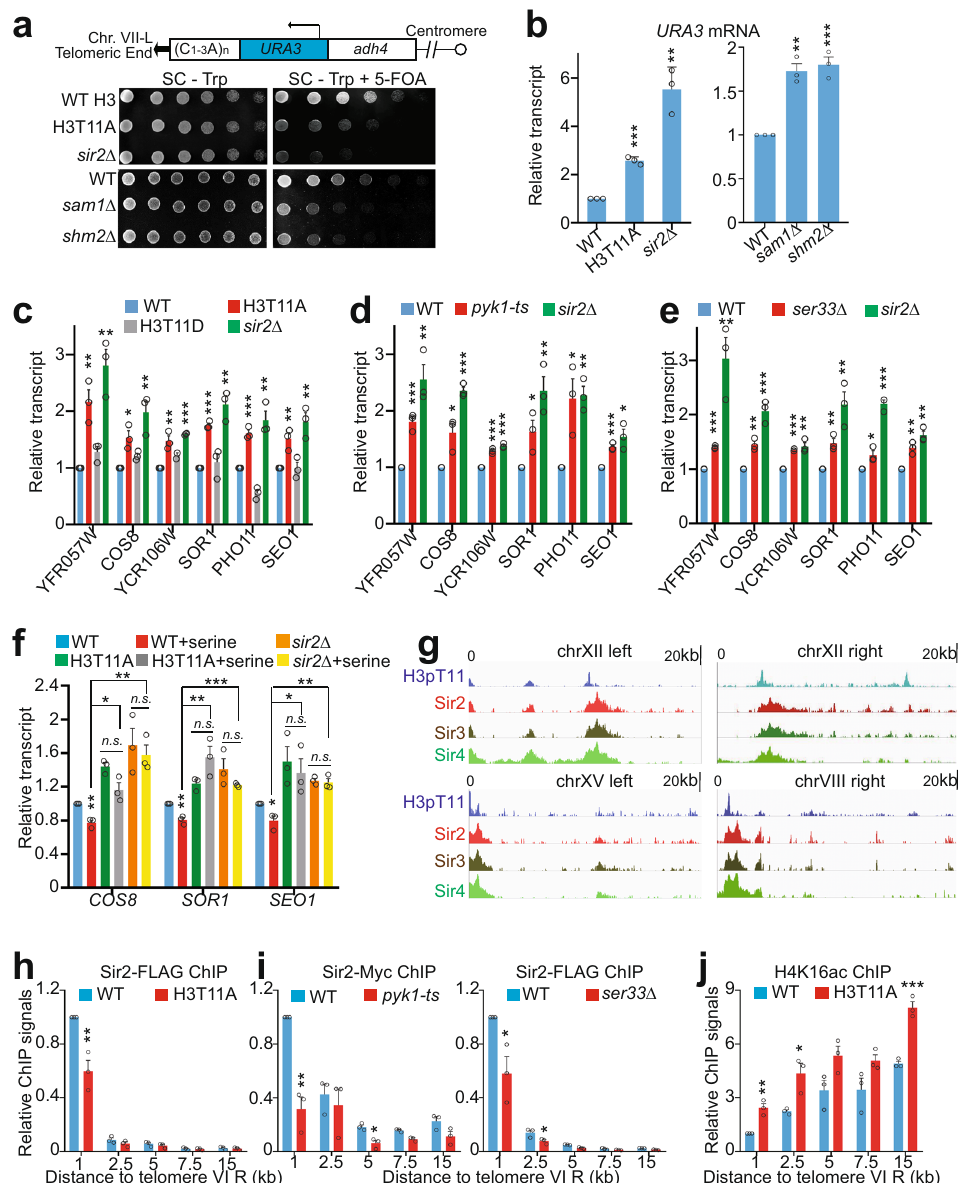
Fig. 2 SESAME-catalyzed H3pT11 promotes SIR complex binding at telomeres and is required to maintain normal telomere silencing. a SESAME- catalyzed H3pT11 is required to maintain telomere silencing. Top panel: Diagram of the position of URA3 inserted near the telomere VII-L in the telomere silencing reporter strain. Bottom panel: WT, H3T11A, sir 2 Δ , sam1 Δ , and shm2 Δ cells bearing URA3 adjacent to Tel VII-L were grown to saturation, normalized for OD 600 , 3-fold serially diluted and spotted on SC - Trp and SC - Trp + 5-FOA plates. Impaired growth on 5-FOA plates indicates diminished silencing of URA3 . b qRT-PCR analysis of URA3 in WT, H3T11A, sir 2 Δ , sam1 Δ , and shm2 Δ mutants. c – e qRT-PCR analysis of native telomere-proximal genes ( YFR057W , COS8 , YCR106W , SOR1 , SEO1 ) in WT, H3T11A ( c ), H3T11D ( c ), pyk1-ts ( d ), ser33 Δ ( e ), and sir 2 Δ mutants. f Effect of serine on the transcription of native telomere-proximal genes ( COS8 , SOR1 , and SEO1 ) in WT, H3T11A, and sir 2 Δ mutants as determined by qRT-PCR analysis. g ChIP-seq tracks showing the enrichment of H3pT11/H3, Sir2, Sir3, and Sir4 at regions within 20 kb of representative telomeres. h , i ChIP analysis of Sir2 occupancy at regions with different distance (1, 2.5, 5, 7.5, and 15 kb) to telomere VI-R in WT, H3T11A ( h ), pyk1-ts ( i ), and ser33 Δ ( i ) mutants. j ChIP analysis of H4K16ac at regions with different distance (1, 2.5, 5, 7.5, and 15 kb) to telomere VI-R in WT and H3T11A mutant. H4K16 acetylation was normalized to its input. For Fig. 2b – f, h – j, the quantitative data represent the mean ± SE; n = 3 biological independent experiments. Statistical signi fi cance was tested using two-sided Student ’ s t test. * p < 0.05; ** p < 0.01; *** p < 0.001. For Fig. 2a, shown are the typical example of three biological independent biological replicates. H3T11D mutant (Fig. 3b). Sir2 protein levels were also signi fi cantly reduced in H3T11A mutant in different strain backgrounds (Sup- plementary Fig. 4b). In contrast, Sir3 and Sir4 were not signi fi cantly changed in H3T11A mutant (Fig. 3b and Supplementary Fig. 4c).